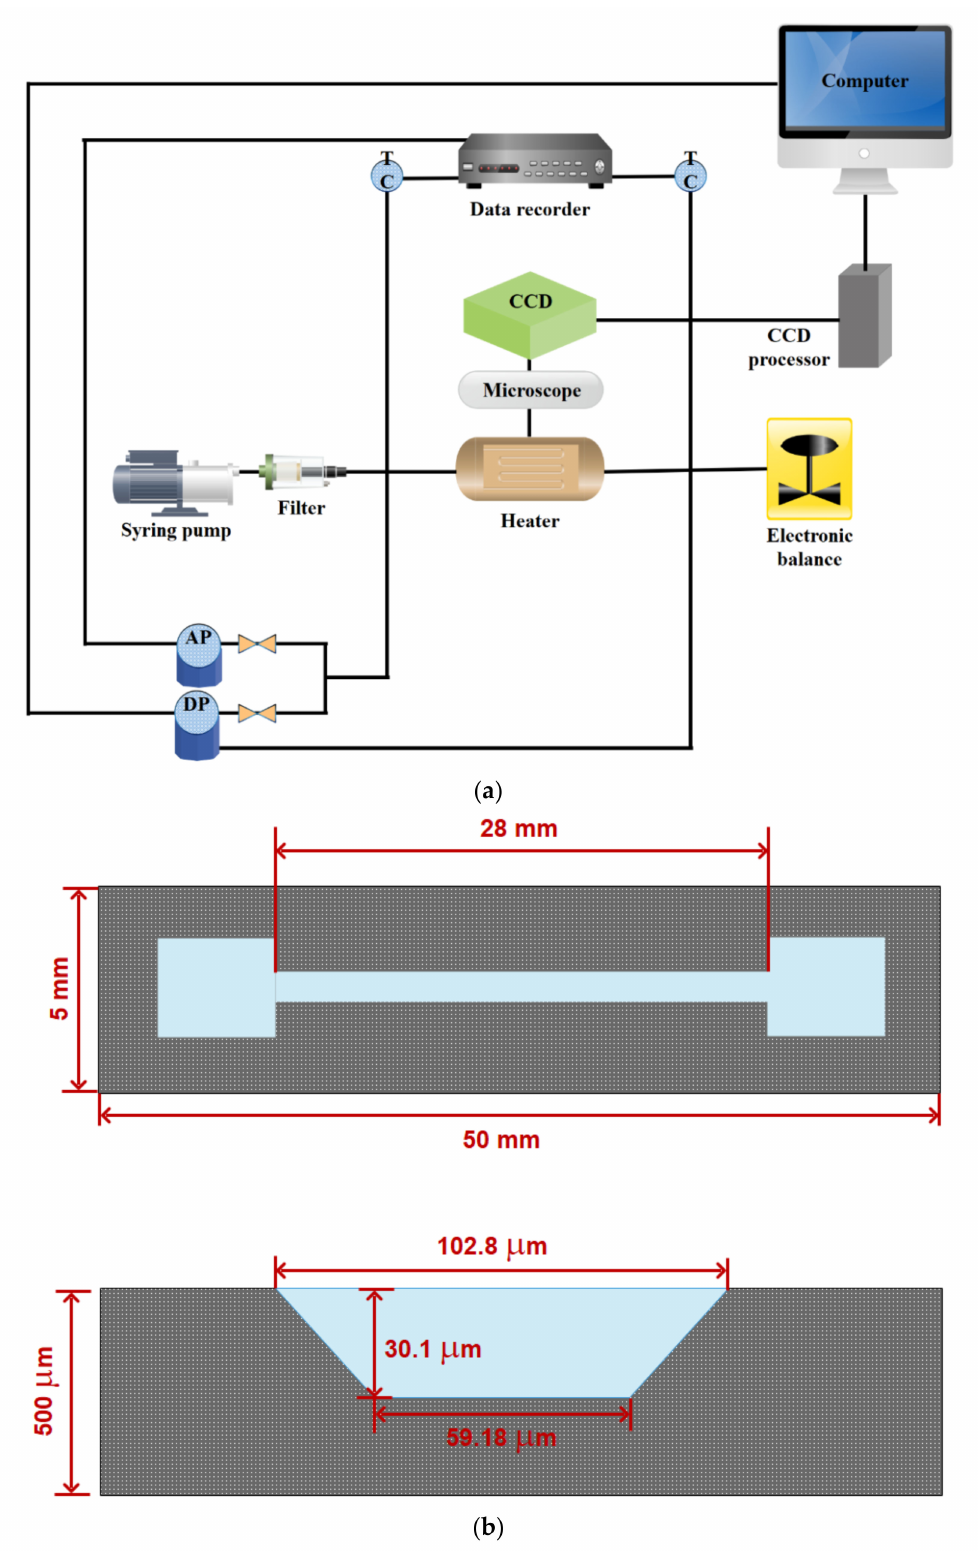
Figure 18. ( a ) Schematic of the experimental setup. ( b ) The top and cross-section views of the test section with a trapezoid microchannel